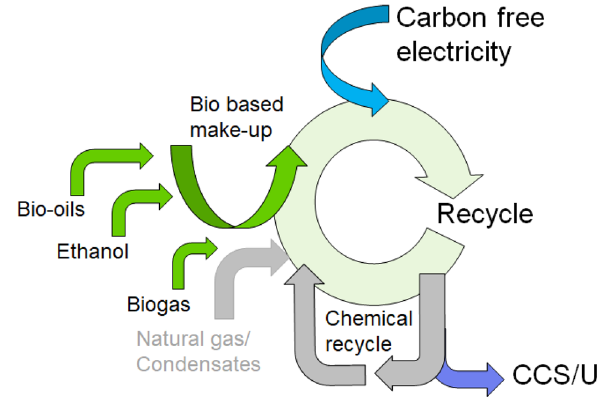
Fig. 6 Conceptual paths to minimum carbon emissions and fossil carbon contents in olefins: bio replacement (green), carbon emis- sion free energy (blue), carbon loss minimization (grey) and carbon emission capture